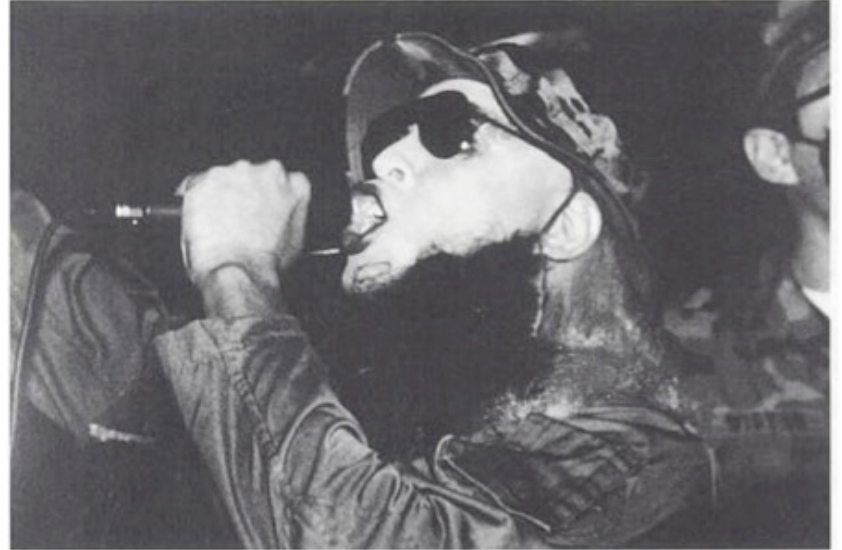
Figure 15. Vaginal Davis in drag king performance mode as Lt. Sargeant Clarence Norbert, leader of Idaho Paramilitary Unit PME – White to be Angry Division @ Empty Bottle, Chicago 1995 photo by tag team Bibbe Hansen/Sean Carillo.